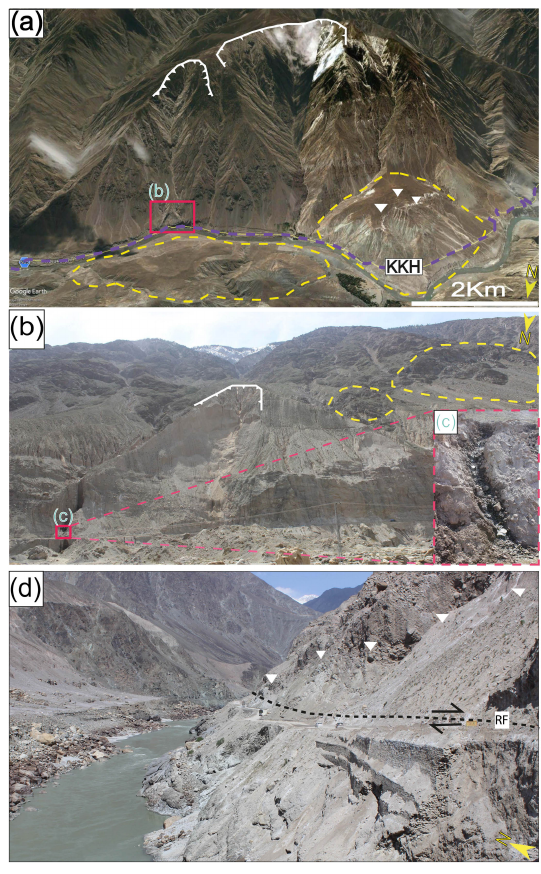
Figure 14. Very high landslide susceptibility near Raikot Bridge (Google Earth, 2017b, Bing Maps) (for location see Box “Y” in Fig. 13b). (a) Overview of 13.4km long small section west of the Raikot Bridge: white lines represent main scarps of large land- slides/rock avalanches, which dammed the Indus River in the past; dotted yellow circles represent deposits of these old landslides; white arrows are showing sagging in landslide deposit which is due to retrogressive rotational failure. (b) White line represents scarp of shallow landslide in alluvial deposits (area in red box of panel a ); area in dotted yellow circles represents ongoing rock/debris fall sup- plying scree/talus for debris flow during rainy season. (c) One of the hot water springs (90–96 ◦ C) along the highway in this section. (d) Another view of small section: white arrows are marking upper limit of the shear zone (ca. 125m wide); dotted black represent- ing active RF marked along shear zone; overhangs above and river erosion below the highway makes this section highly susceptible to slope failures.